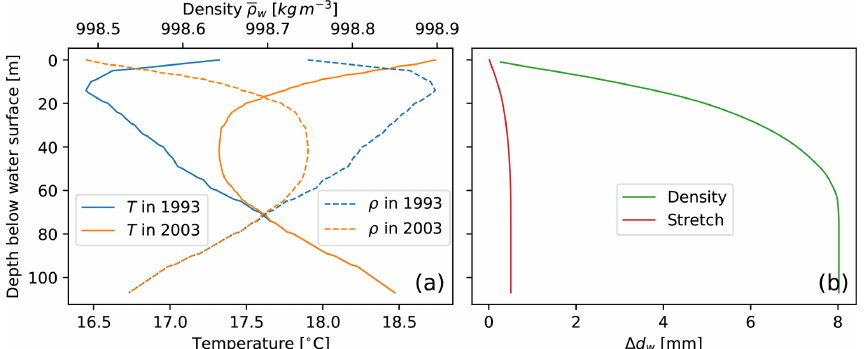
Figure 8. (a) Temperature and average density as a function of depth for an observation well in Japan that experienced significant warm- ing due to urbanisation between 1993 and 2003. Temperature data from Yamano et al. (2009). (b) Theoretical head increase due to the temperature-related density decrease and head increase that would be perceived if the PT’s vertical position is lowered due to thermal expan- sion of the steel suspension